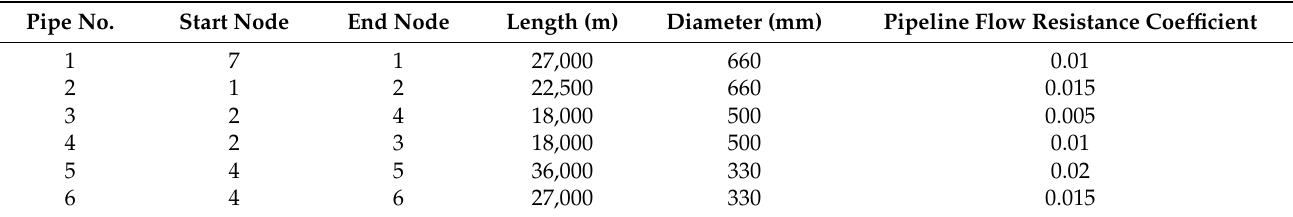
Table A1. Parameters of the seven-node natural gas network in the case study.